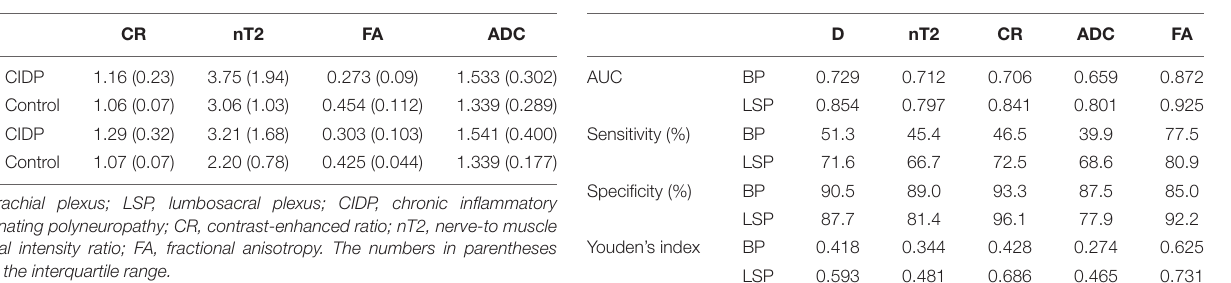
TABLE 2 | Multiparameters for brachial and LS plexi 2 . TABLE 3 | ROC curve analysis on single-parameter model 3 .